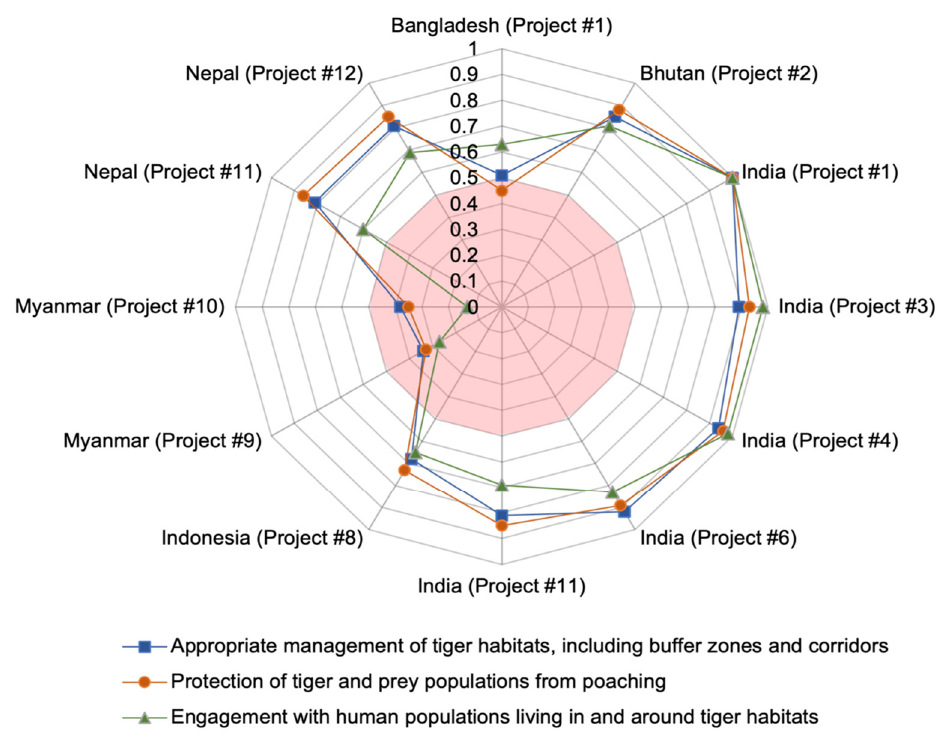
Figure 3. Mean CA|TS Lite assessment score for the ITHCP pillars and corresponding categories for each CA|TS-assessed ITHCP project: 1 = Recognized—Action Implemented, 0.75 = Recognized— Action Initiated, 0.5 = Recognized—Action in Planning Process, 0.25 = Recognized—No Action Initiated, 0 = Not Recognized—Action Absent. Categories that score below 0.5 (shown in light red) are considered to be insufficiently addressed [24].